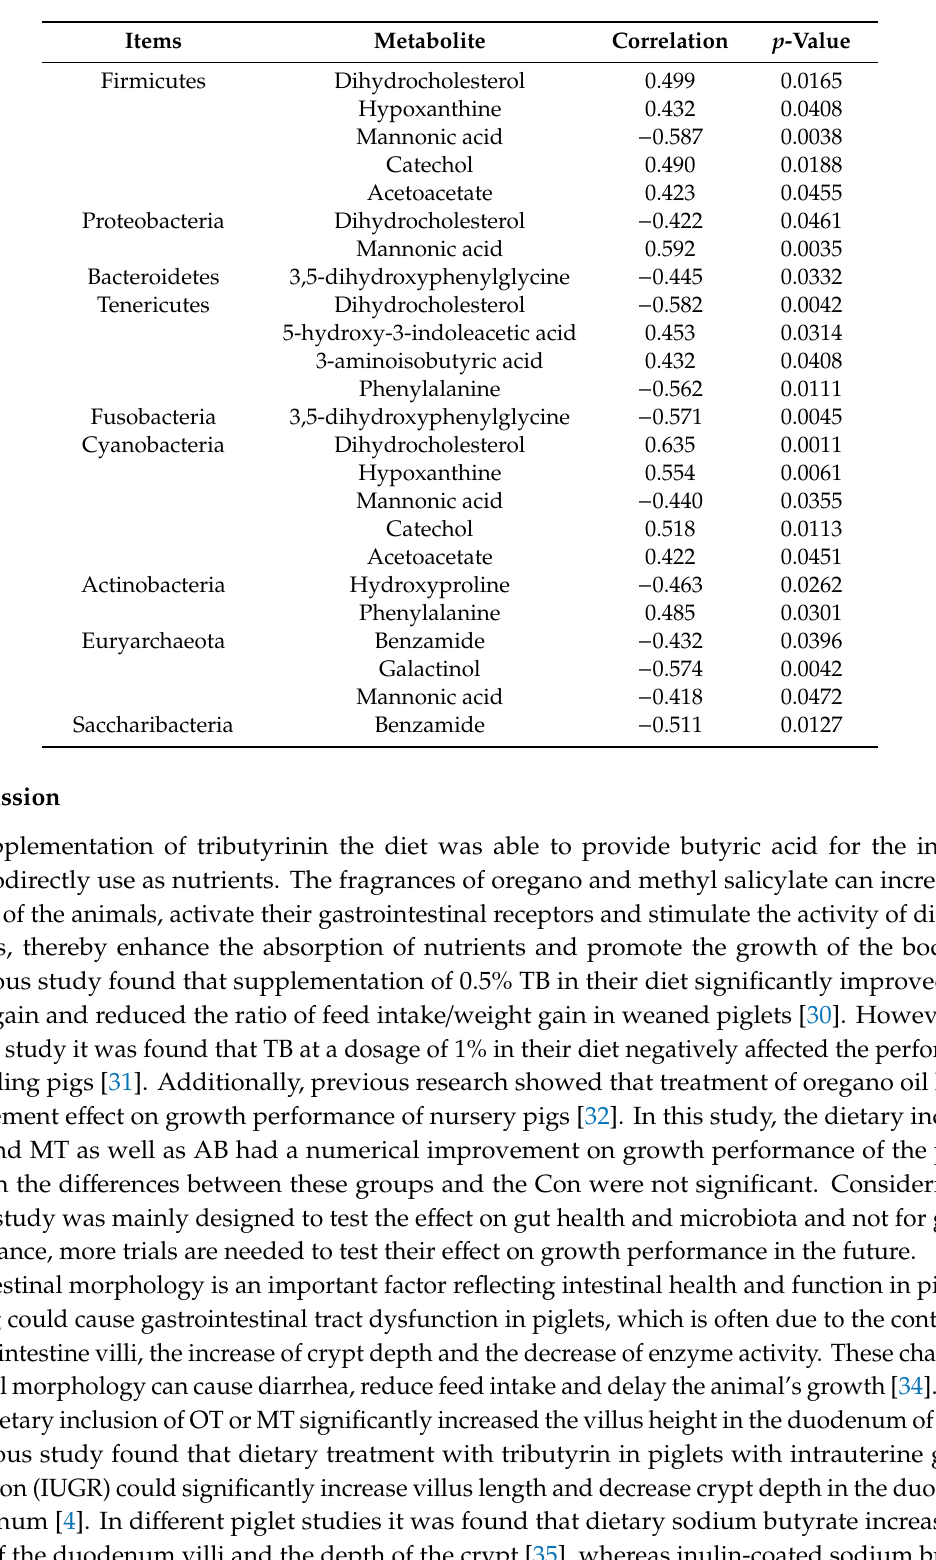
Table 10. Interaction of characteristic floras and metabolites based on Pearson correlation coe ffi